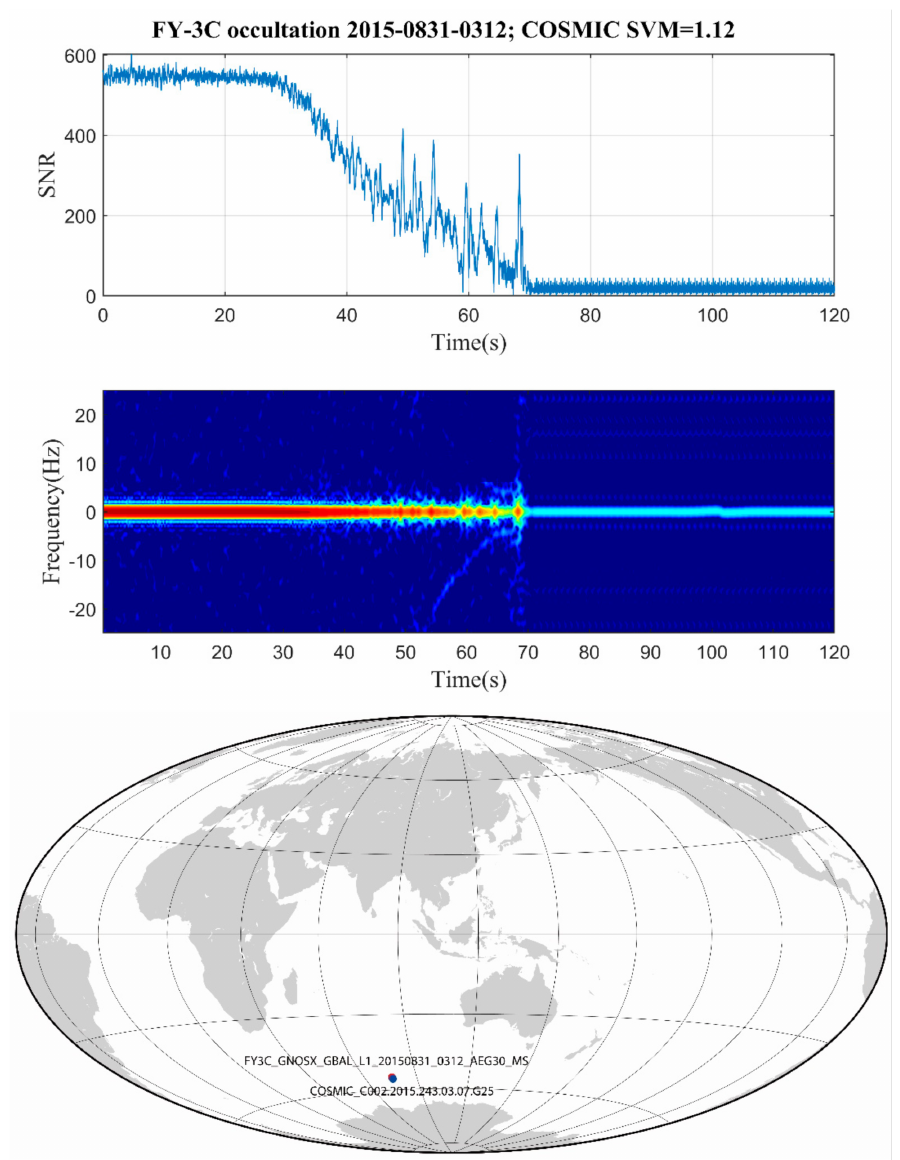
Figure 5. FY-3C event on 31 August 2015: received SNR of L1 channel ( upper panel), radio holo- gram spectrum from FY-3C Level_1 data ( middle panel), geographical location of FY-3C event ( bottom